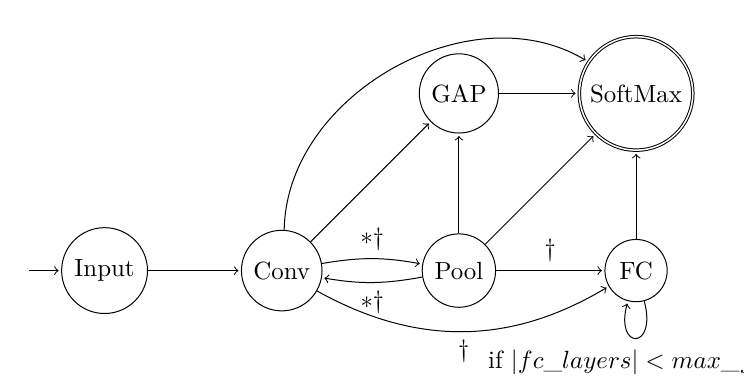
Figure 2: Original Markov Decision Process for generating a CNN architecture in MetaQNN: The actions in the process are the addition of specific layers to the neural network being generated. ∗ Only allows transitions to layers with a smaller size than the current representation size. † Only available if the current layer depth is smaller than the maximum configured. ‡ max_fc was set to three in Baker et al.